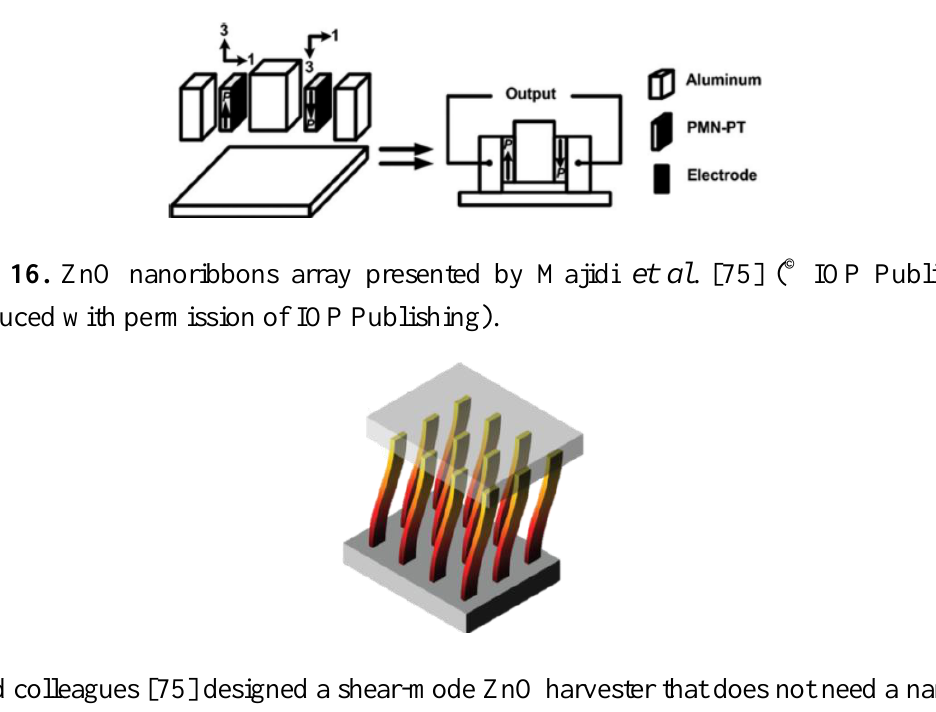
Figure 15. Nonresonant device presented by Ren and colleagues ( © 2010 IEEE. Reprinted with permission from [74]).